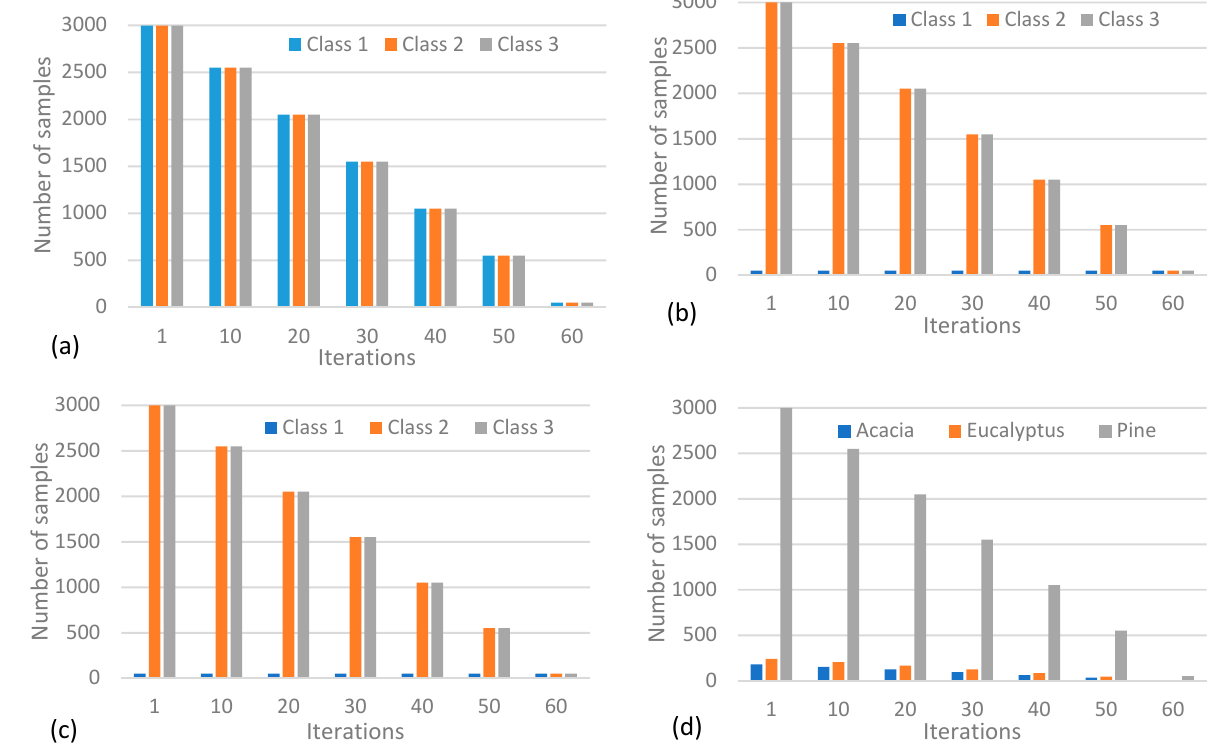
Figure 5. Summary of every 10th iteration of how the sample subsets were selected for Experiment A ( a ), Experiment B ( b ), Experiment C ( c ), and Experiment D ( d ). Experiment B was run three times for all iterations, keeping a different class constant at 50 samples. Experiment C was also run three times for all iterations, keeping two different class combinations constant at 50 samples.